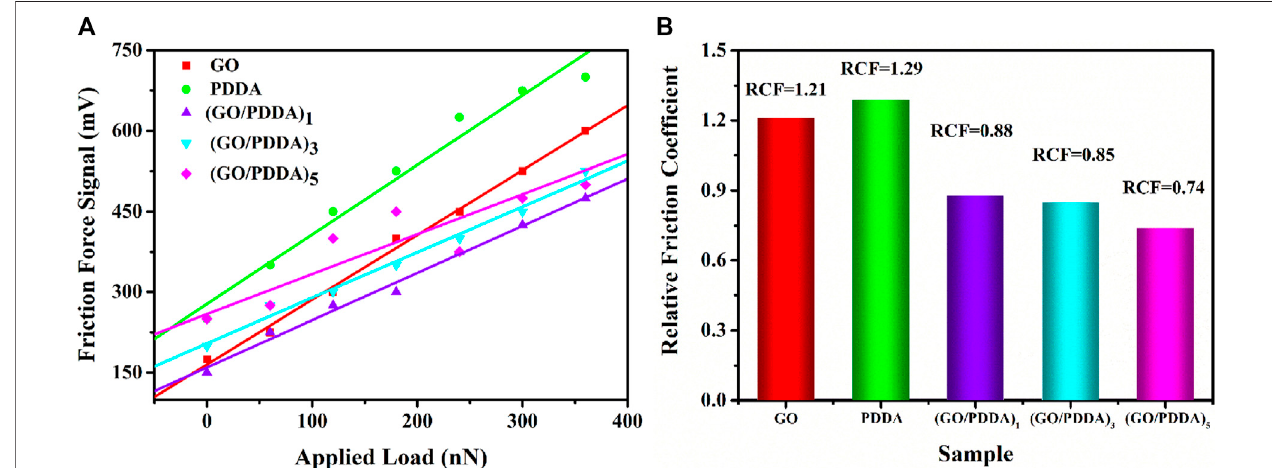
FIGURE 8 | Variation in friction coef fi cient with time for various sample at different applied loads and a sliding frequency of 1 Hz: (A) 0.1 N; (B) 0.2 N; (C) 0.3 N; (D) 0.4 N.